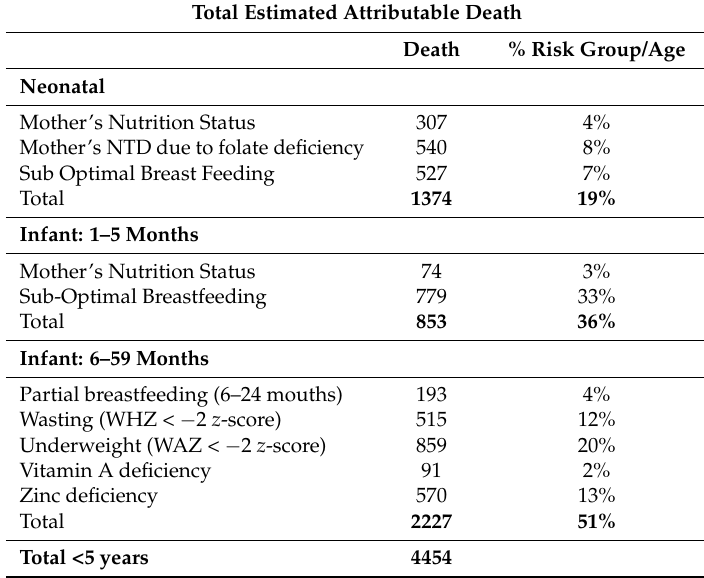
Table 5. Mortality among Children under 5 Years of Age associated with Key Indicators of Malnutrition.